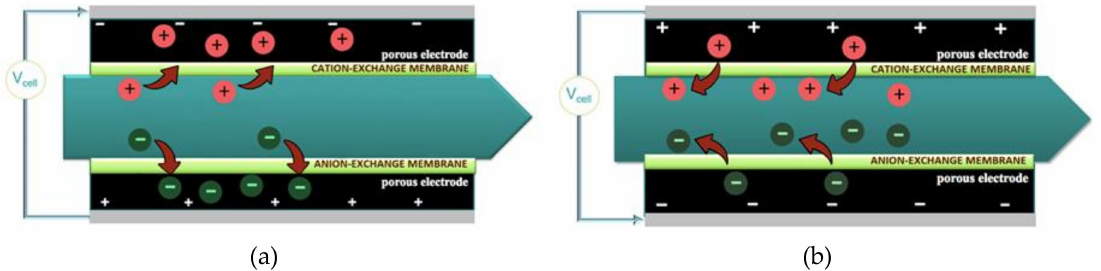
Figure 1. Scheme of membrane capacitive deionization: ( a ) electrosorption and deionization and ( b )